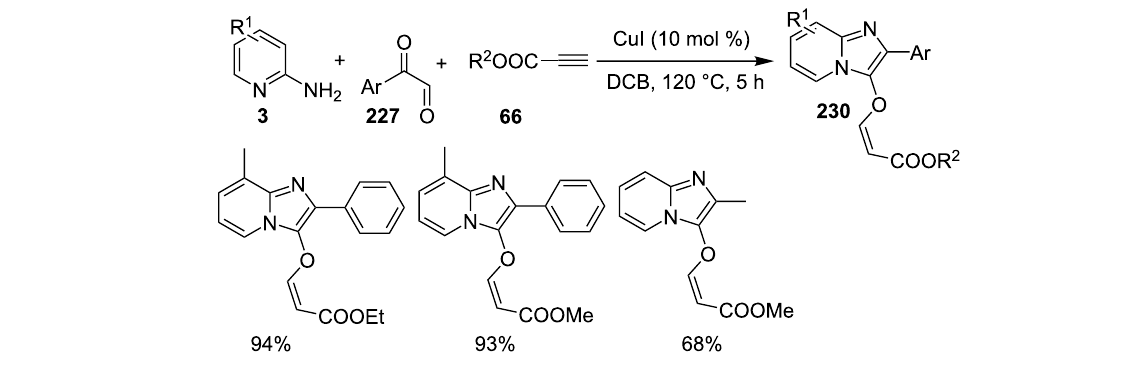
Scheme 78: Regioselective product formation with propiolates.